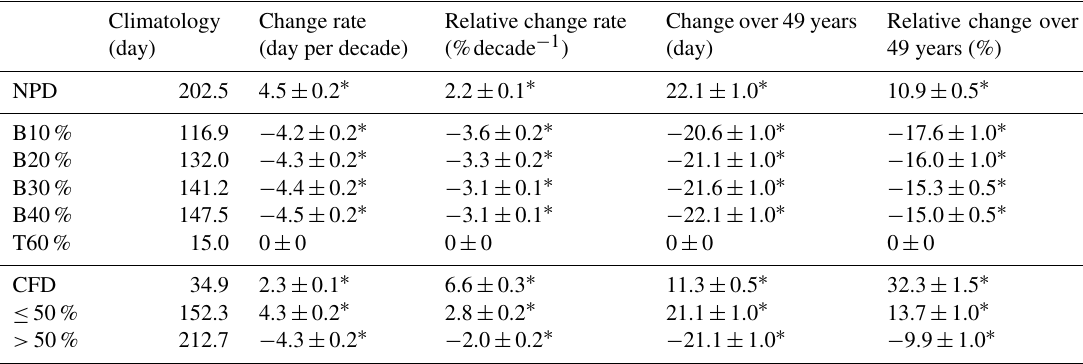
Table 2. Climatology and days changed for precipitation days and cloudy days.